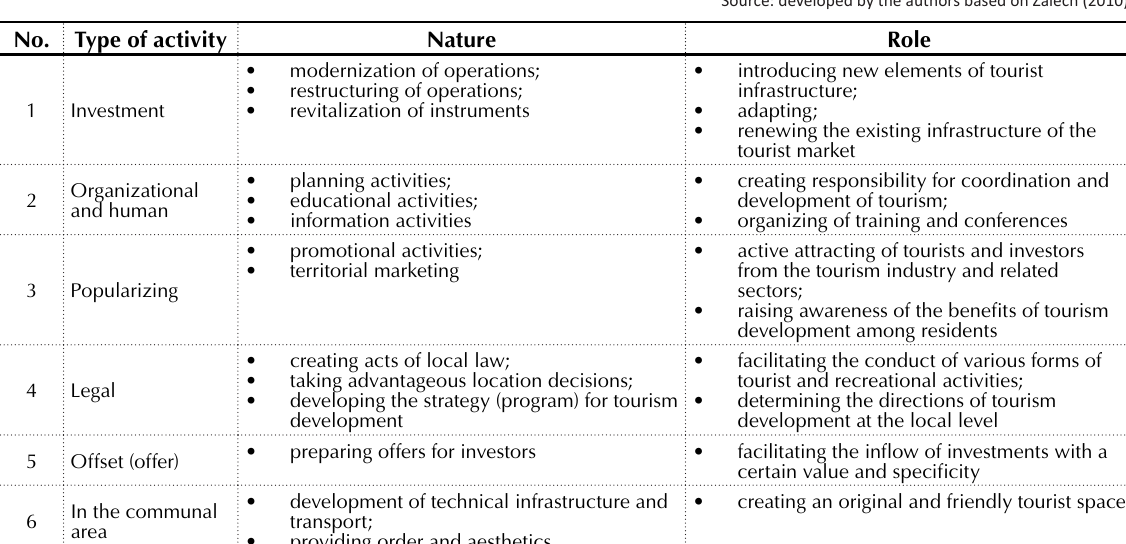
Table 1. Possible impact of local authorities on tourism development